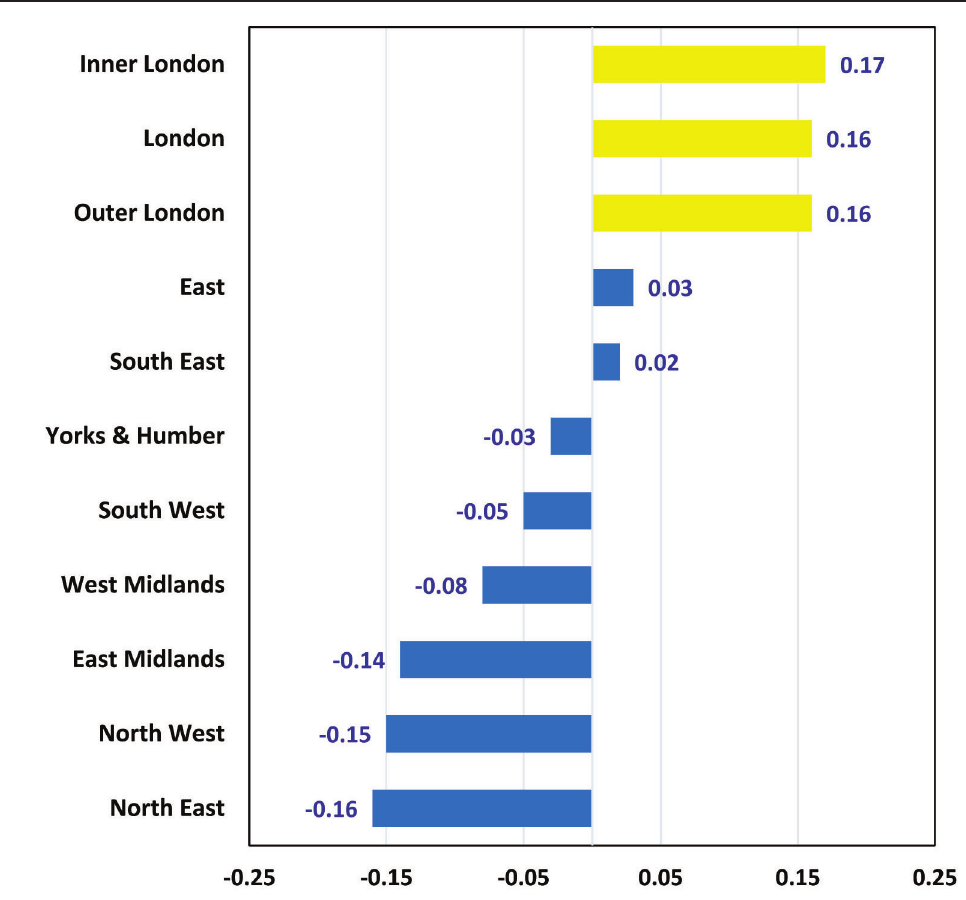
Figure 7: Average Progress 8 scores by English region at Key Stage 4 in